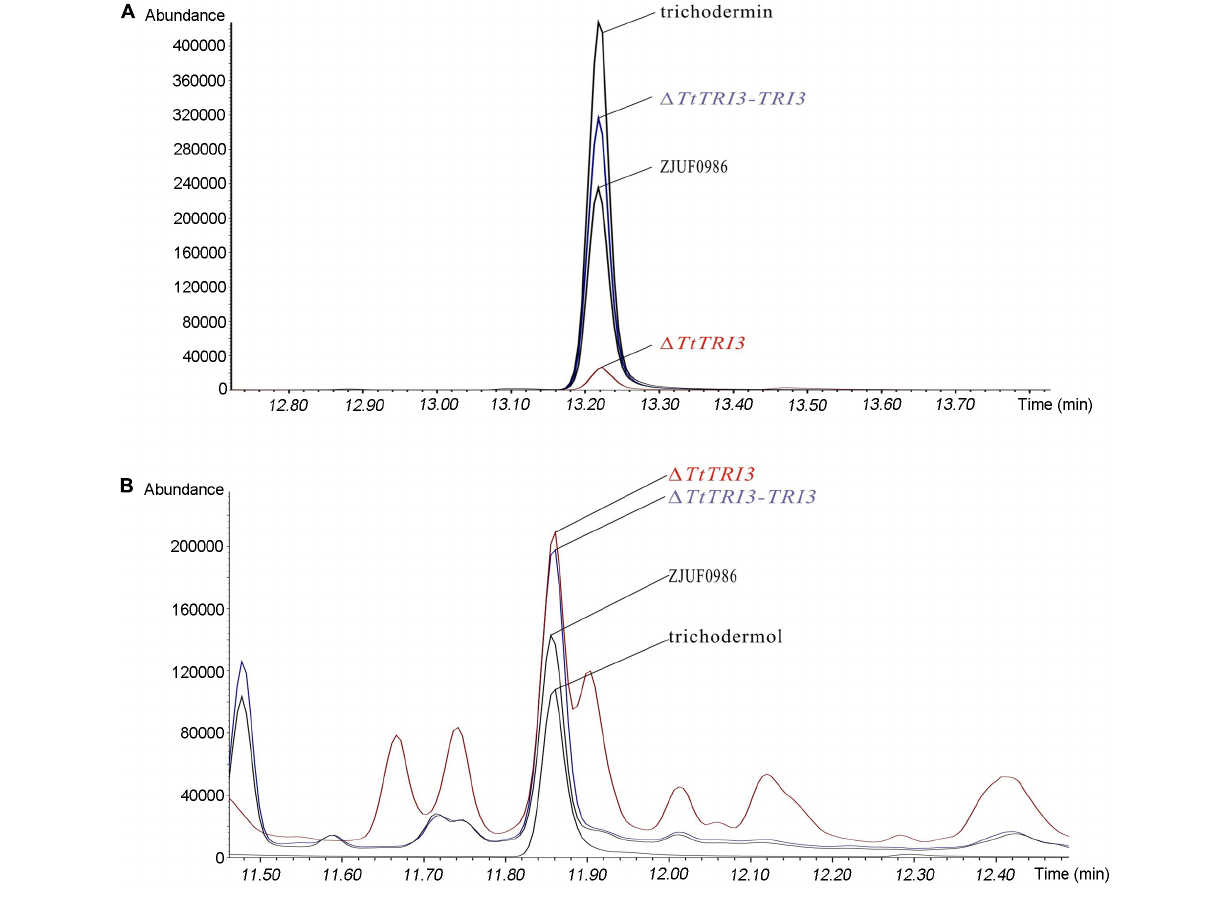
FIGURE 5 | Trichodermin and trichodermol production in strain ZJUF0986, (cid:49) TtTRI3 , and (cid:49) TtTRI3-TRI3 . Amount of trichodermin (A) and trichodermol (B) in fermentation broth was detected by gas chromatography (GC)–MS. Peaks for trichodermin and trichodermol were determined by the corresponding reference chemicals. The concentration of reference chemicals in the prepared samples was 188 ppm (part per million) for trichodermin and 42 ppm for